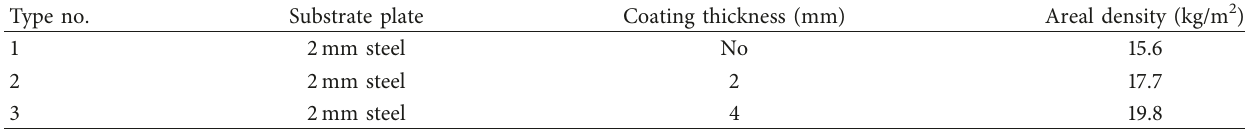
Table 3: Areal density of different types of test plates.